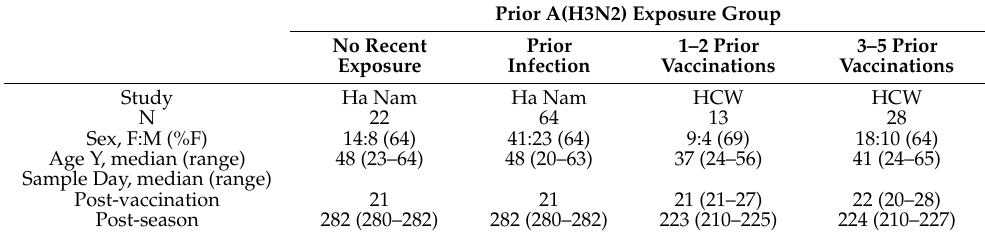
Table 2. Age and sex of participants in each prior exposure group.